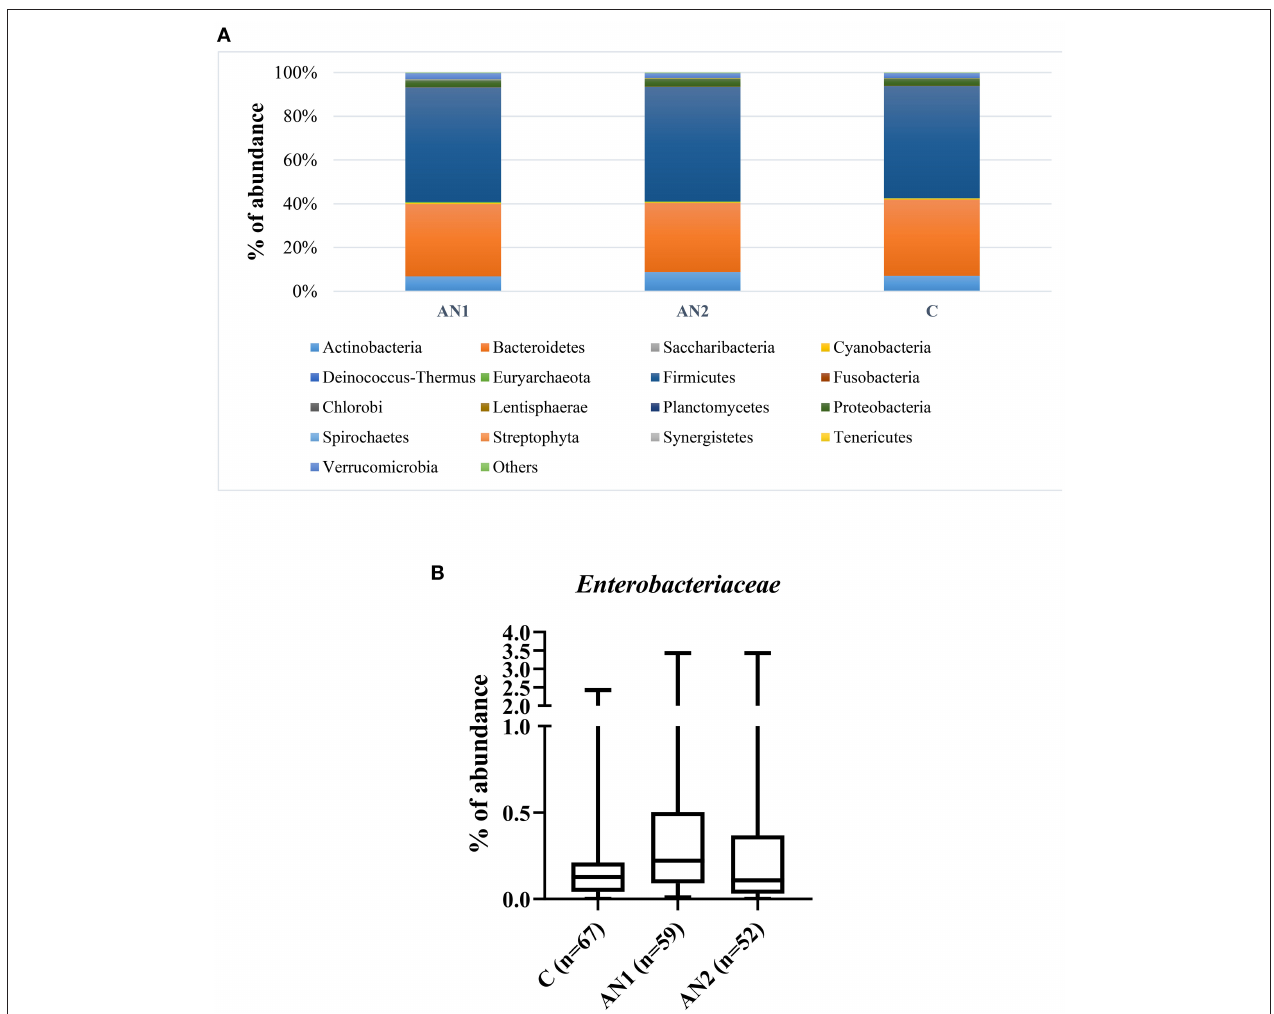
FIGURE 2 | The bacterial phylum composition of healthy controls and patients’ gut microbiome (A) . The Enterobacteriaceae family abundance within these groups (B) . decreased in patients with AN compared to healthy